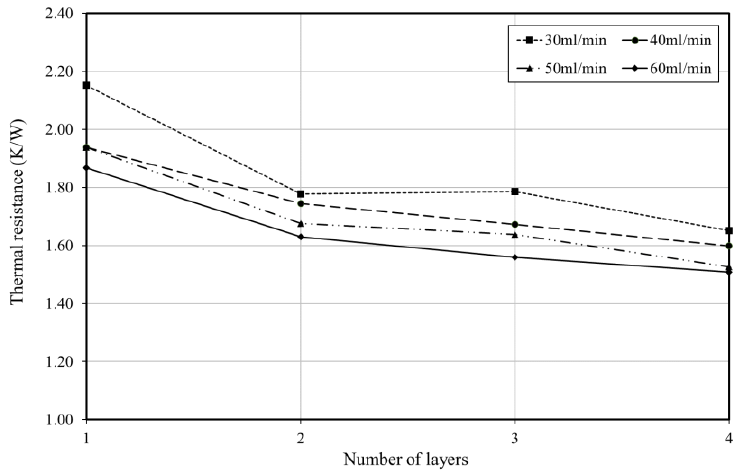
Figure 18. Heat sink thermal resistance versus number of layers for different HTF flow rates for 30 W.